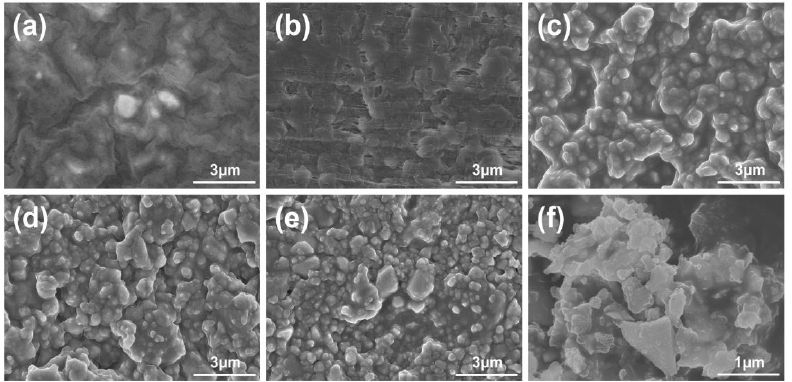
Figure 2. SEM images of composite electrolytes with different LATP content. ( a – f ) Represent 50% LATP, 60% LATP, 70% LATP, 80% LATP, and 90% LATP composite electrolytes, and pristine LATP electrolyte, respectively.